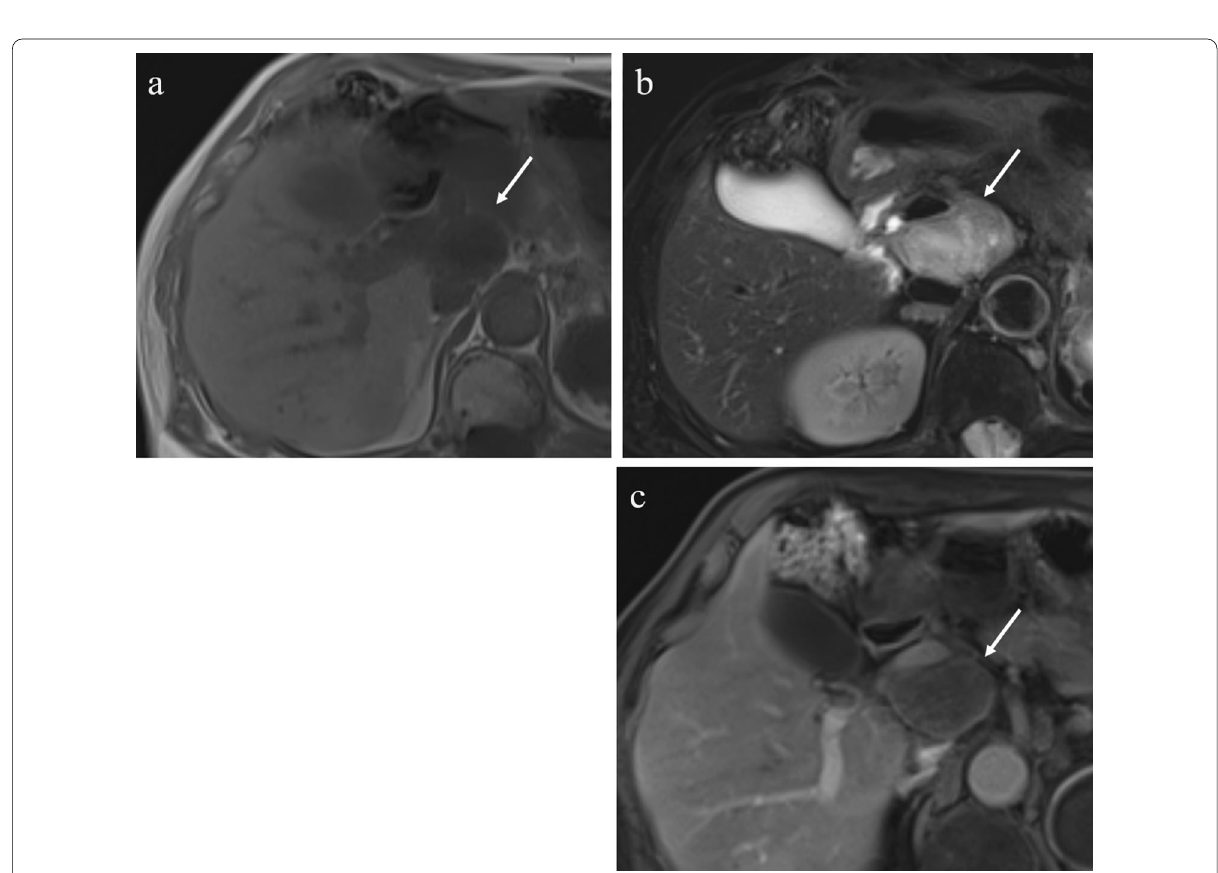
Fig. 2 Abdominal magnetic resonance imaging findings. a The tumor (white arrow) showed hypointensity on T1-weighted images. b The tumor (white arrow) showed mixed hypointensity and hyperintensity on T2-weighted fat-suppression images. c Abdominal contrast-enhanced MRI revealed that the peripheral margin of the tumor (white arrow) was enhanced in the arterial phase. MRI magnetic resonance